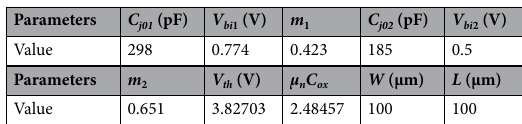
Table 1. Parameters of the IRF510 MOSFET.